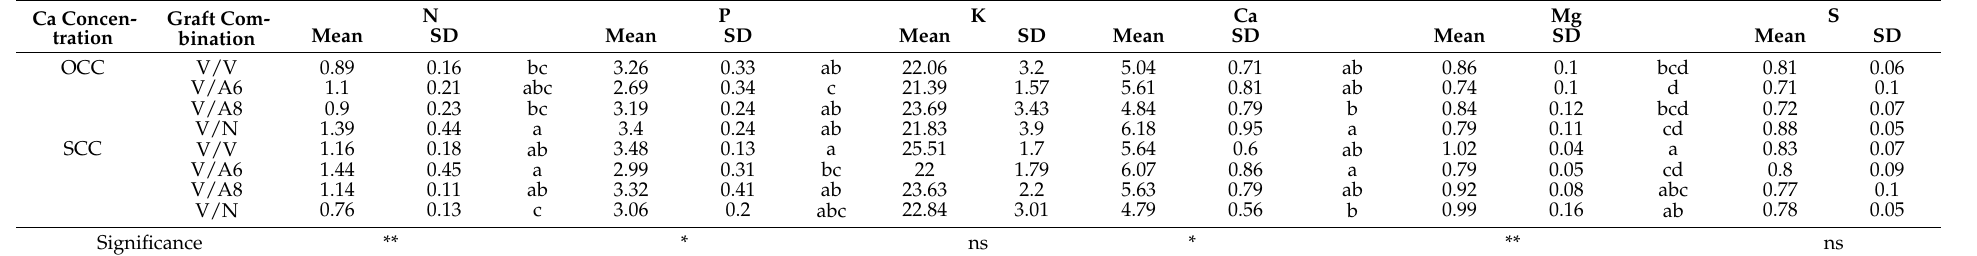
Table 3. Effects of calcium concentration and plant combinations on mineral composition (N total, P, K, Ca, Mg and S—g/kg DW) of pepper fruits at the end of the experiment (98 DAT).